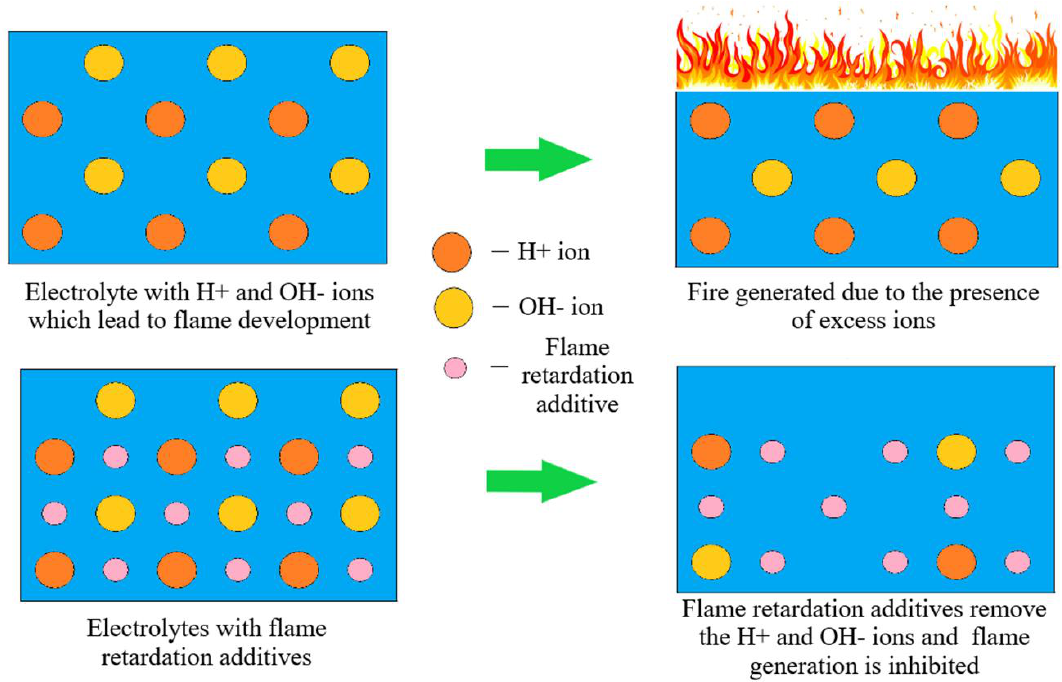
Figure 17. Removal of H + and OH − ions by adding flame retardation additives.